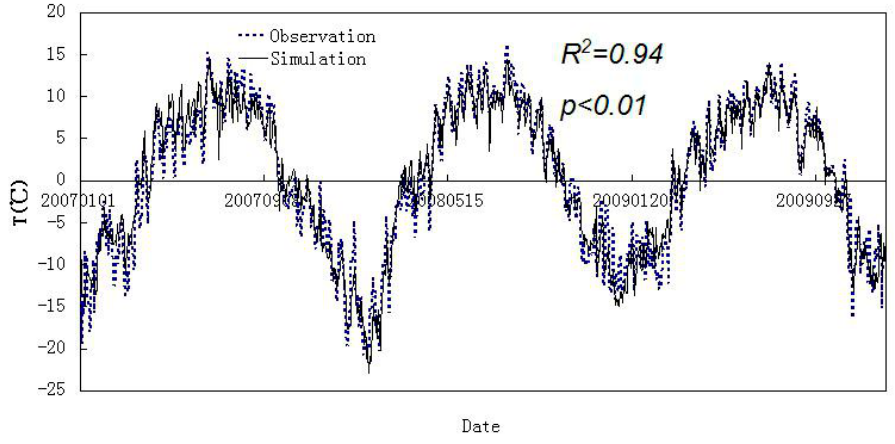
Figure 4. Comparison of simulated and observed daily temperature at Camp ‐ AWS from 2007 to 2009. y = 4.7353x + 982.53 R 2 = 0.3932